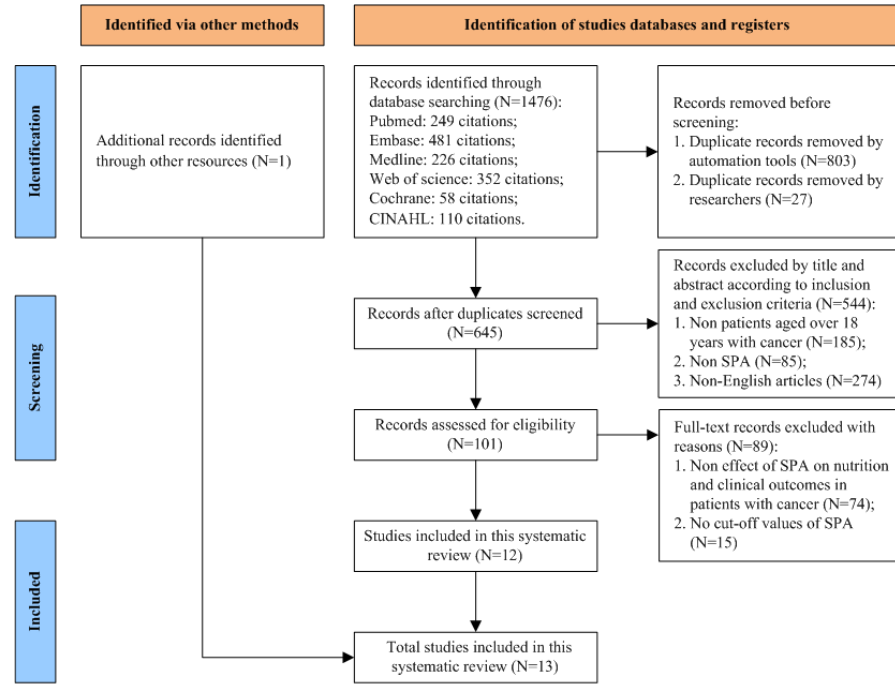
Figure 1. Flow diagram for study selection. Table 2. Characteristics of included cancer patients.